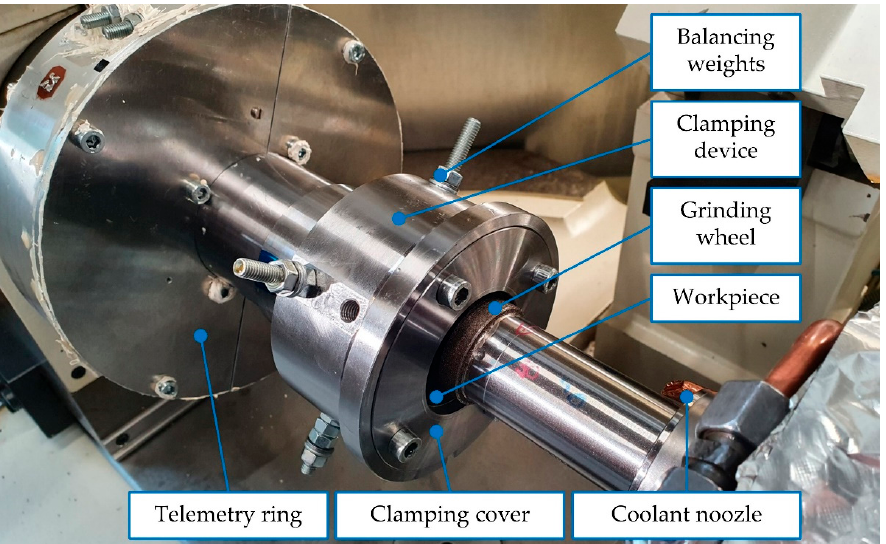
Figure 3. Experimental setup for internal traverse grinding tests. The telemetry ring has not been used for the experiments presented in this work. used for the experiments presented in this